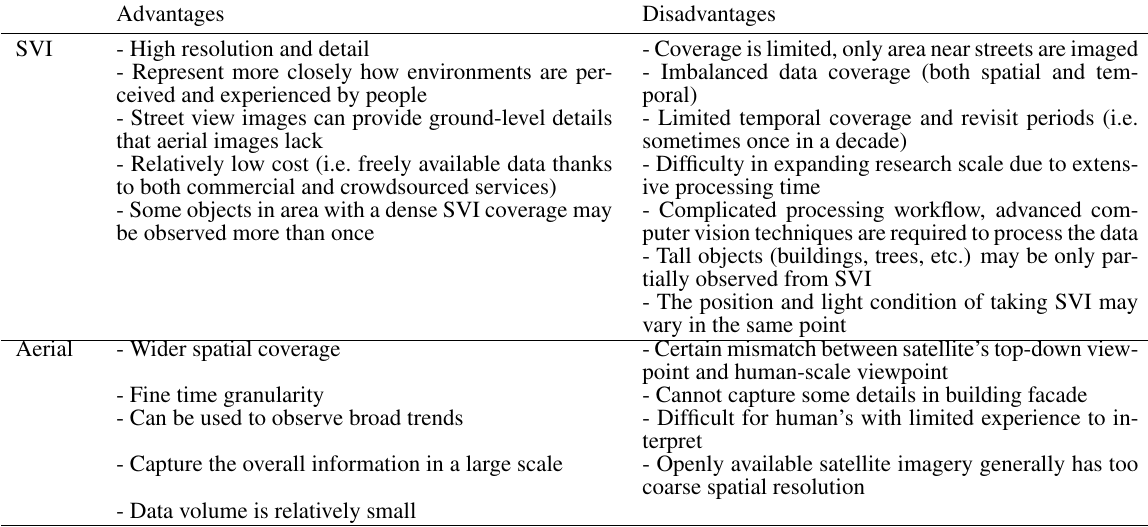
Table 2. Comparison of the general advantages and disadvantages of SVI and aerial imagery in studies of the built environment. reach. Moreover, sometimes only major roads are imaged.